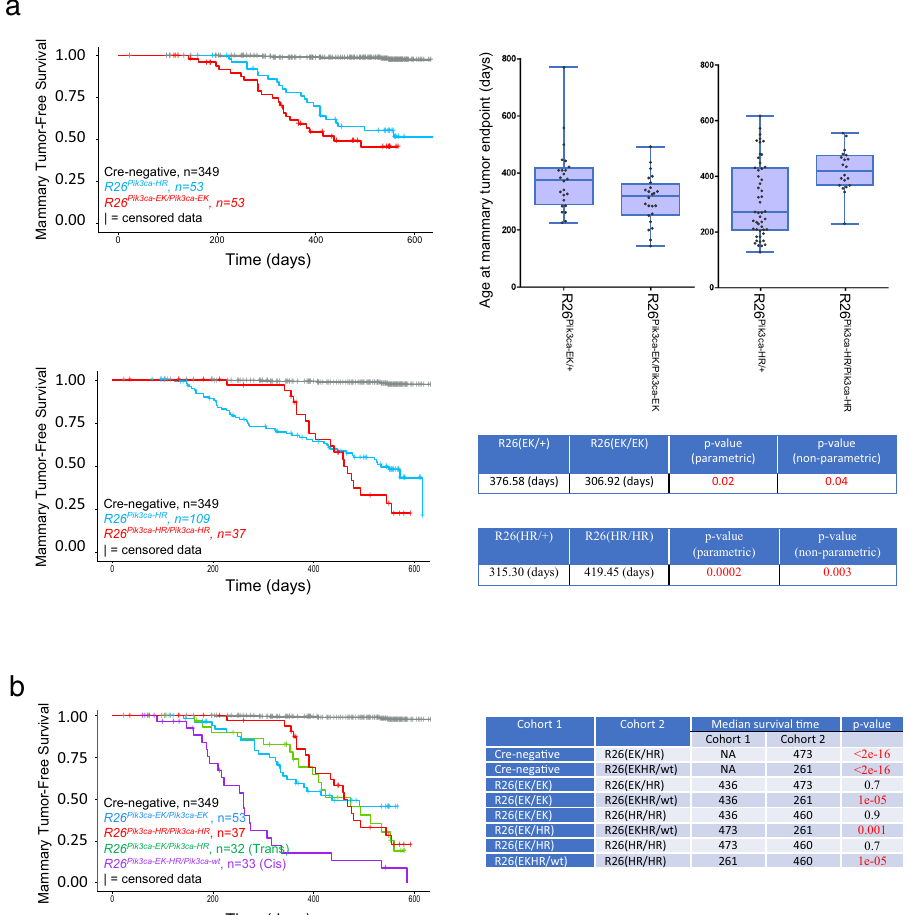
Fig. 10 Genetic analysis of PI3K-induced mammary tumor formation de fi nes cooperation between multiple pathway mutations. Two copies of R26-LSL- Pik3ca E545K lower, while two copies of R26-LSL- Pik3ca H1047R raise, the age at mammary tumor endpoint ( a ). Kaplan – Meier survival analysis of Pik3ca hotspot mutations. Two-sided parametric t -test p -values were computed using the “ t test ” function in R. Two-sided non-parametric test p -values were computed using the “ wilcox.test ” function, also in R. Based on multiple testing ( n = 3), p -values of less than 0.03 are considered signi fi cant. E545K and H1047R hotspot mutations show dramatic cooperation in cis in comparison to trans ( b ). Note, total Pik3ca transgene dose was controlled through ectopic expression of Pik3ca wt (by crossing in a R26-LSL-Pik3ca wt allele). Mice in each cohort were also positive for MMTV-Cre NLST . For b two-sided p -values from the log-rank test comparing two survival curves were calculated using the “ survdiff ” function from the R/Bioconductor package “ survival ” . For each box and whisper plot, the center line represents the median. Also, box limits represent (lower) 25th to (upper) 75th percentiles. Whiskers show the min and max values. There was one EK/ + outlier (770 days). No outliers were identi fi ed for other Pik3ca H1047R . These data, together with the surprisingly small overlap in gCIS identi fi ed as cooperating mutations in Pik3- ca E545K vs. Pik3ca H1047R screens, the selection for non-classical hotspot mutations as second site allelic enhancers in BC, as well as evidence for unique signaling pathways downstream of each mutant 58,59 , support a model whereby many breast tumors select for just enough and just right signaling within the PI3K signaling pathway(s).